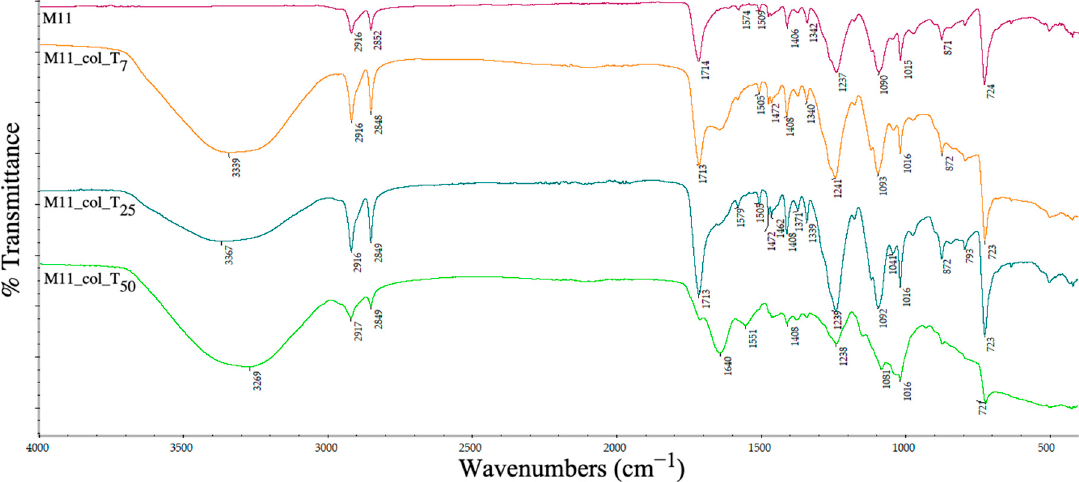
Figure 23. ATR spectra of PET–HDPE composite pellets before and after collagen deposition at days 7 (T 7 ), 25 (T 25 ) and 50 (T 50 ).